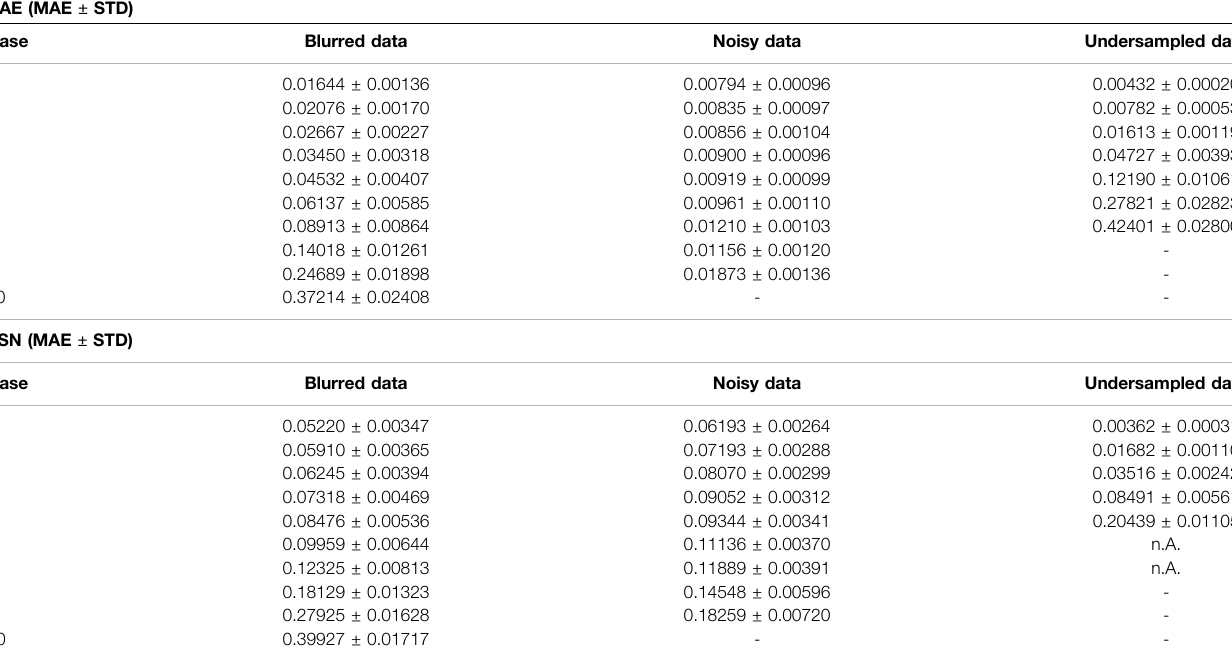
TABLE 3 | Comparison of the MAE obtained when applying the CAE method and the ESN method to the test data set. CAE (MAE ± STD) Case Blurred